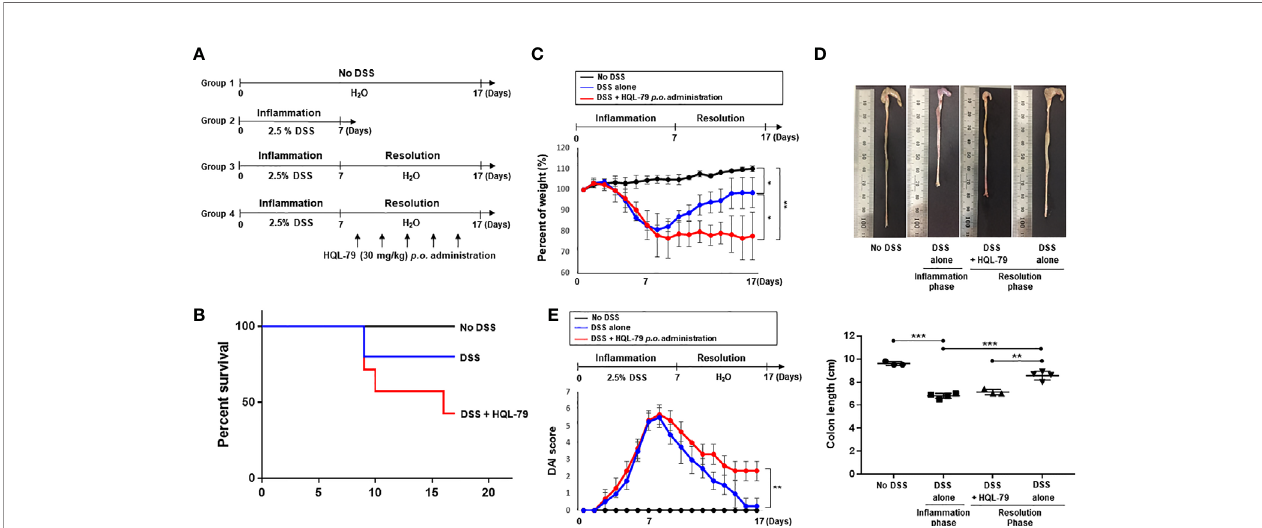
FIGURE 2 | Inhibition of HPGDS leads to the failure in resolution of DSS-induced intestinal in fl ammation. (A) Mice were given with drinking water containing 2.5% DSS for 7 days, followed by normal water for another 10 days. HQL-79 (30 mg/kg) was administrated orally for 10 days every other day. (B) The survival rate, (C) the change in the body weight, and (D) DAI score were monitored every day during the experiment period. The survival rate of the mice was expressed by using Kaplan – Meier plot. (E) The colon length was measured when mice were sacri fi ced. All data represent mean ± S.D. (n = 3 or 4). * p < 0.05, ** p < 0.01, and *** p < 0.001.